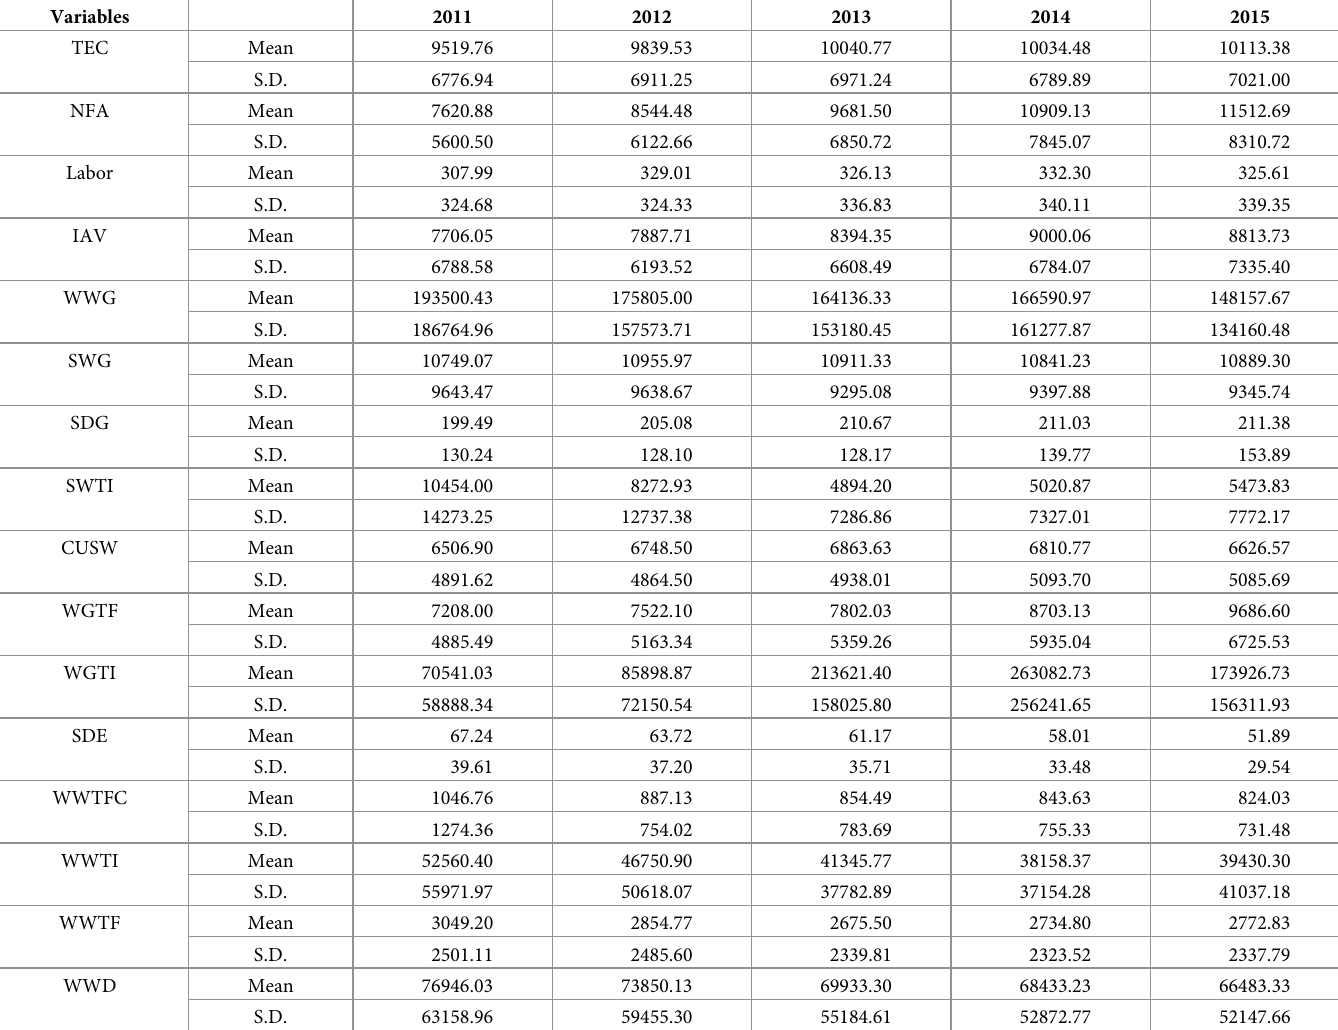
Table 2. Descriptive statistics of